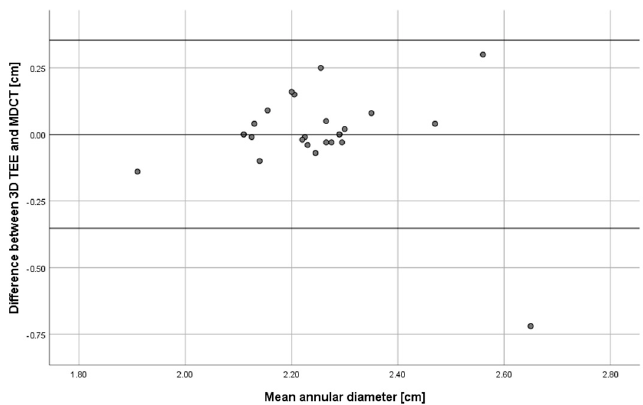
Figure 3. Bland-Altman plot showing agreement between TEE and MDCT measurements of aortic annulus diameter applied to images obtained from 25 patients.